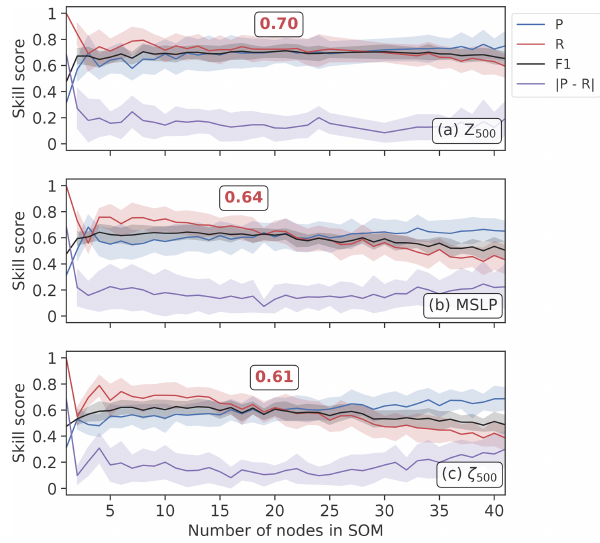
Figure 8. A comparison of the SOM blocking index performance for three variables in 101 years from the UKESM pre-industrial control period with a varying number of nodes in the SOM. Pre- cision ( P ), recall (R) and F1 scores are calculated, and the absolute difference between precision and recall is also shown. Error bands show the standard deviation ( ± 1 σ ). The red number inset into each panel shows the optimal F1 score, and the position of the box in- dicates the corresponding node number. As above, the largest F1 score is for Z 500 , indicating that Z 500 is the best variable tested for analysing blocking patterns using the SOM-BI in UKESM.